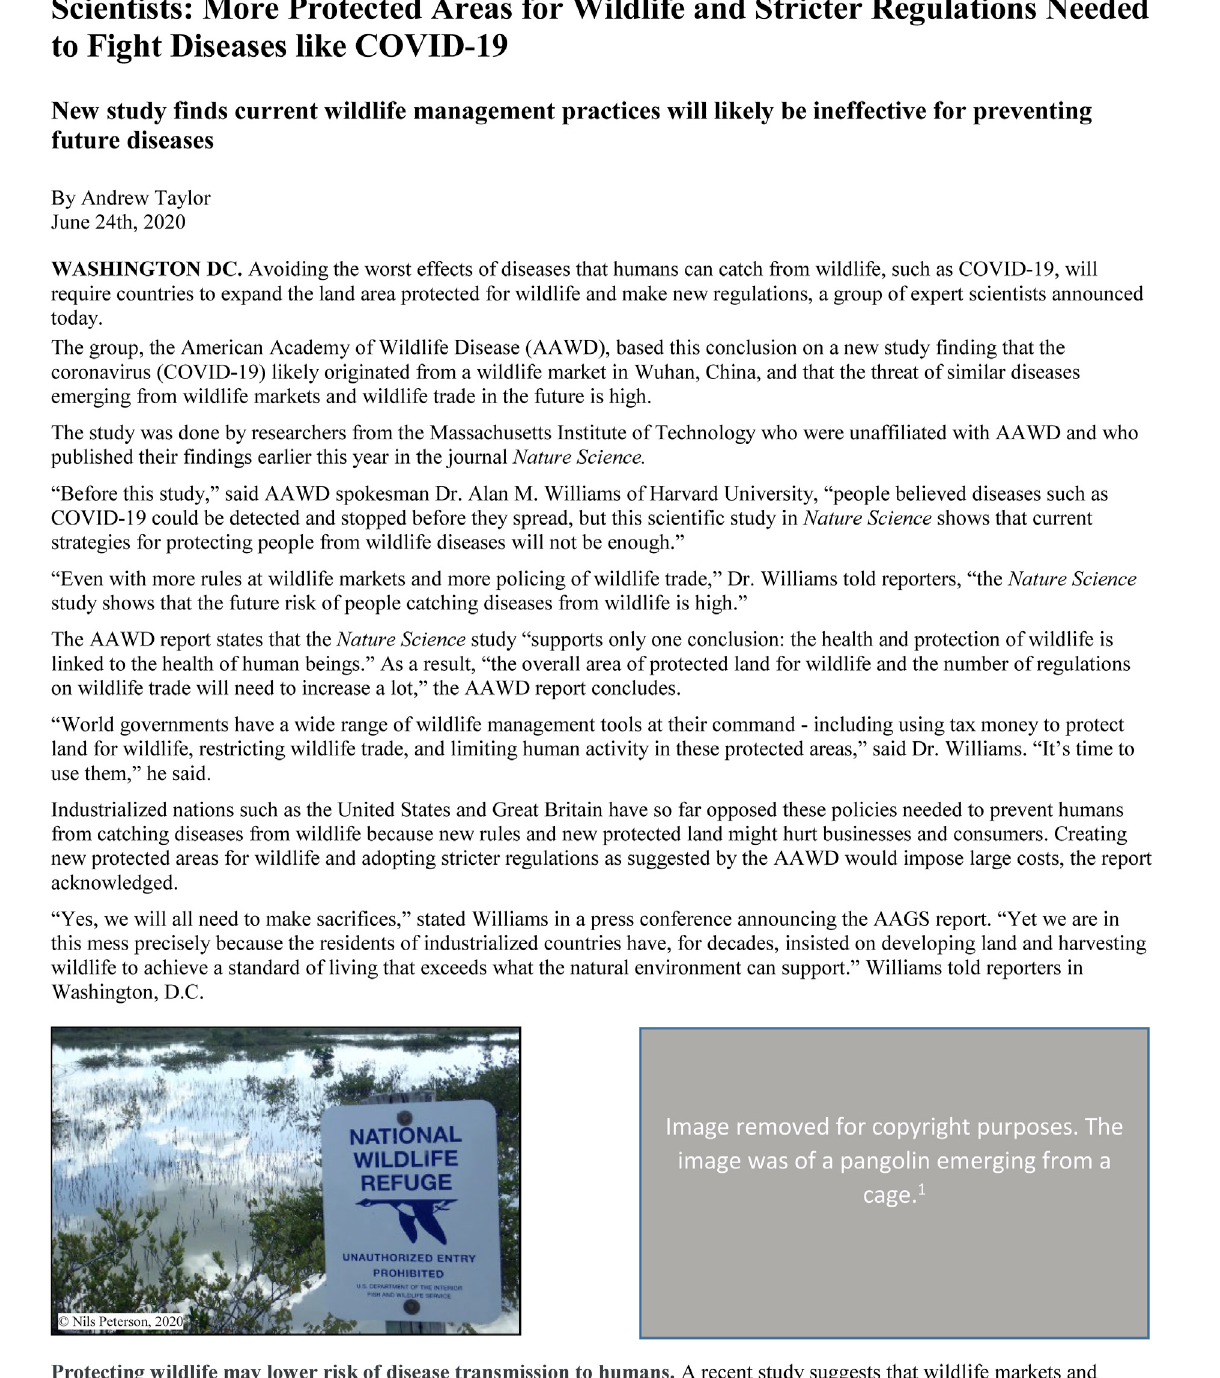
Frontiers in Communication |